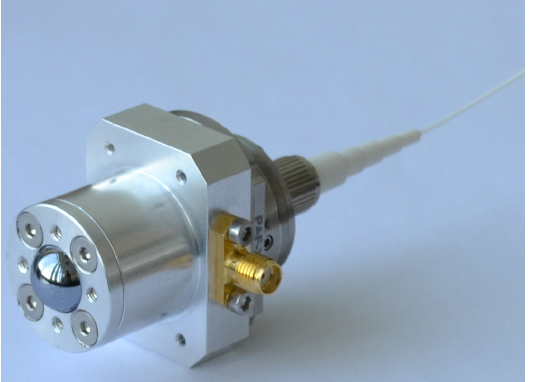
Figure 1. Photo of fiber-coupled optoelectronic GaAsBi-based THz emitter mounted with a silicon lens. Courtesy of Laboratory of Ultrafast Optoelectronics Laboratory at Optoelectronics Department at FTMC and Teravil Ltd., Vilnius,